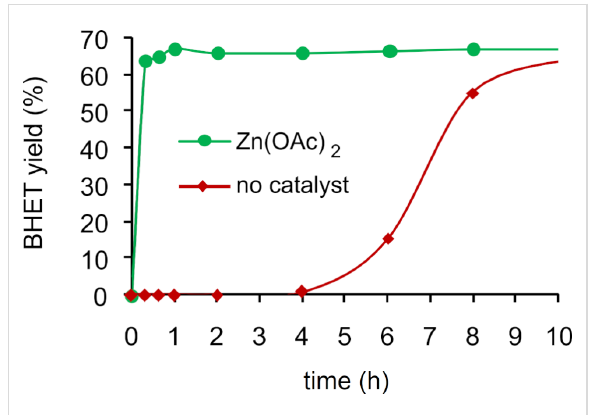
Figure 4: Glycolysis of PET: evolution of BHET yield over time, with and without zinc acetate catalyst (196 °C, EG/PET ratio 2.45 (w/w). Data from reference